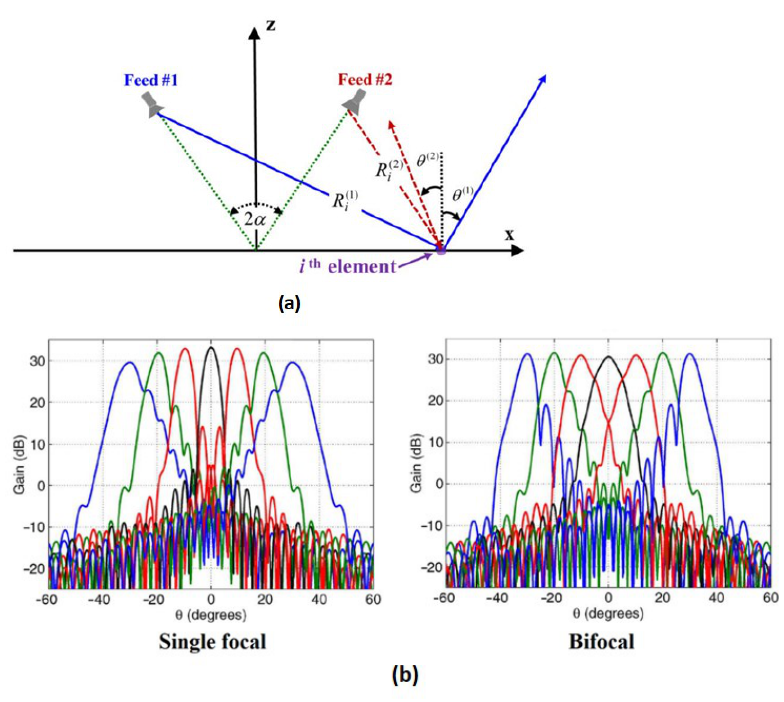
Figure 9. ( a ) Schematic of bifocal reflectarray antenna. ( b ) Scanned gain patterns of single and bifocal reflectarray designs (Reprinted with permission from